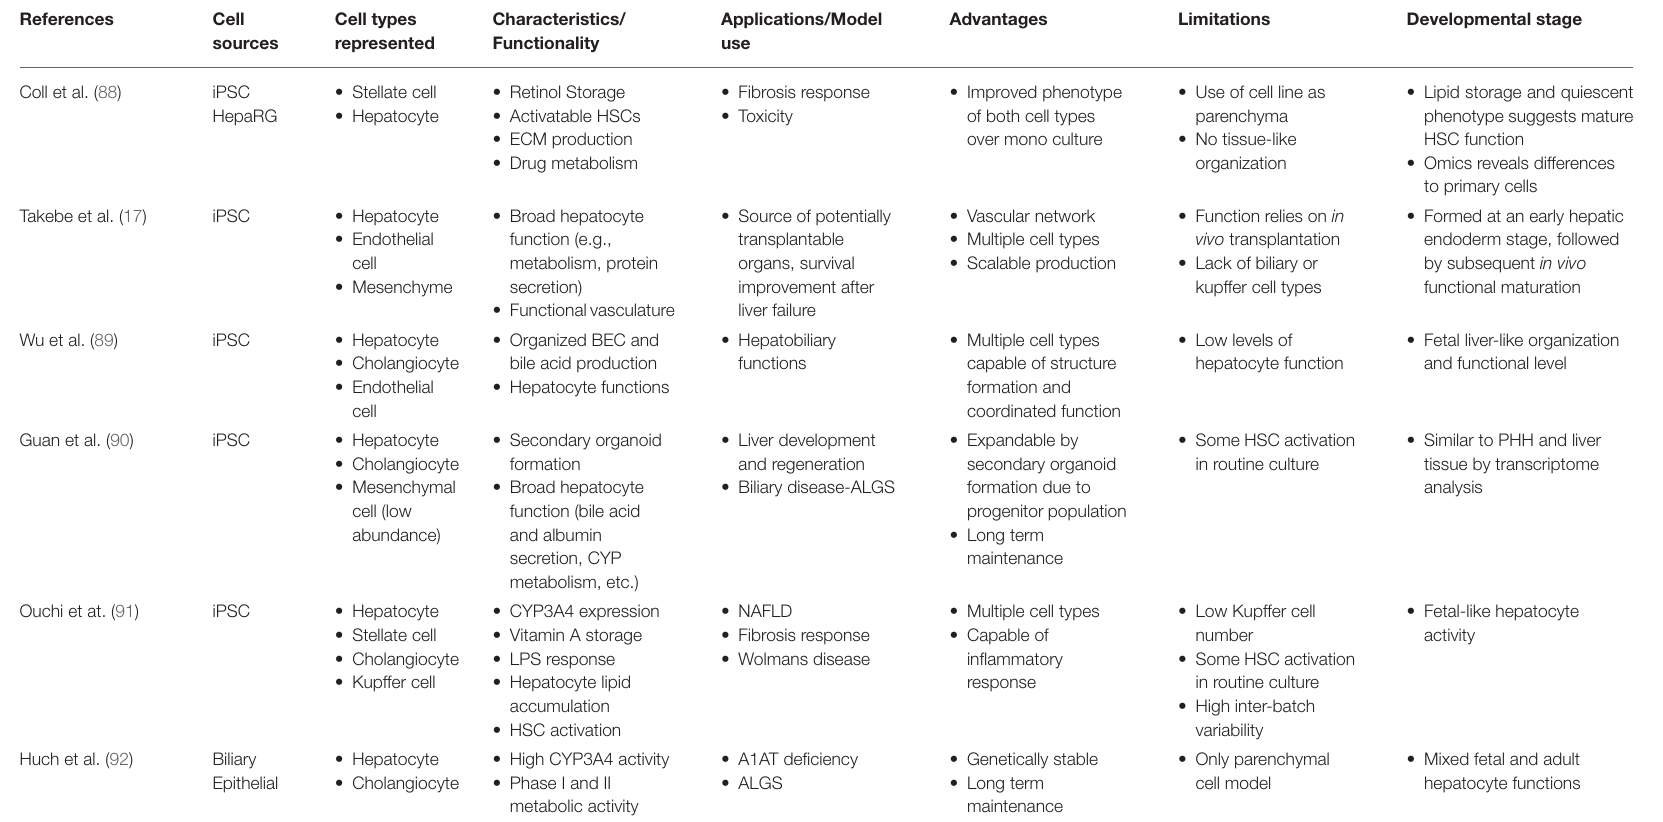
TABLE 1 | Overview of 3D Liver